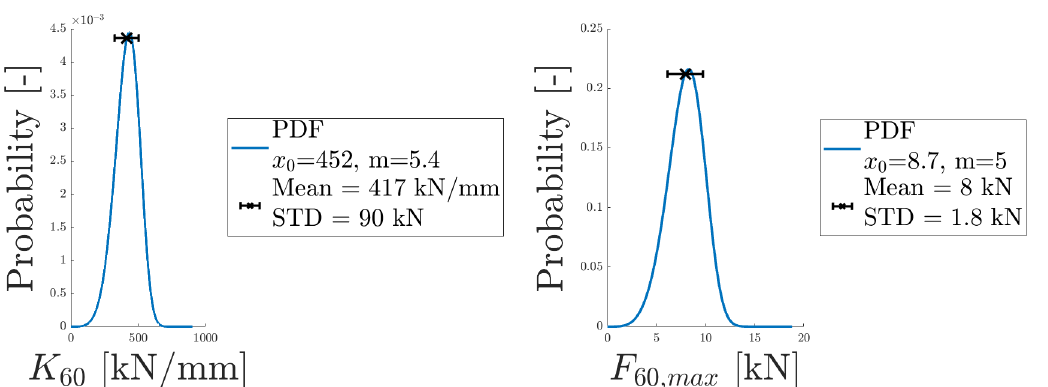
Figure 22. Probability distributions, obtained from the determined Weibull parameters, are presented for each parameter in